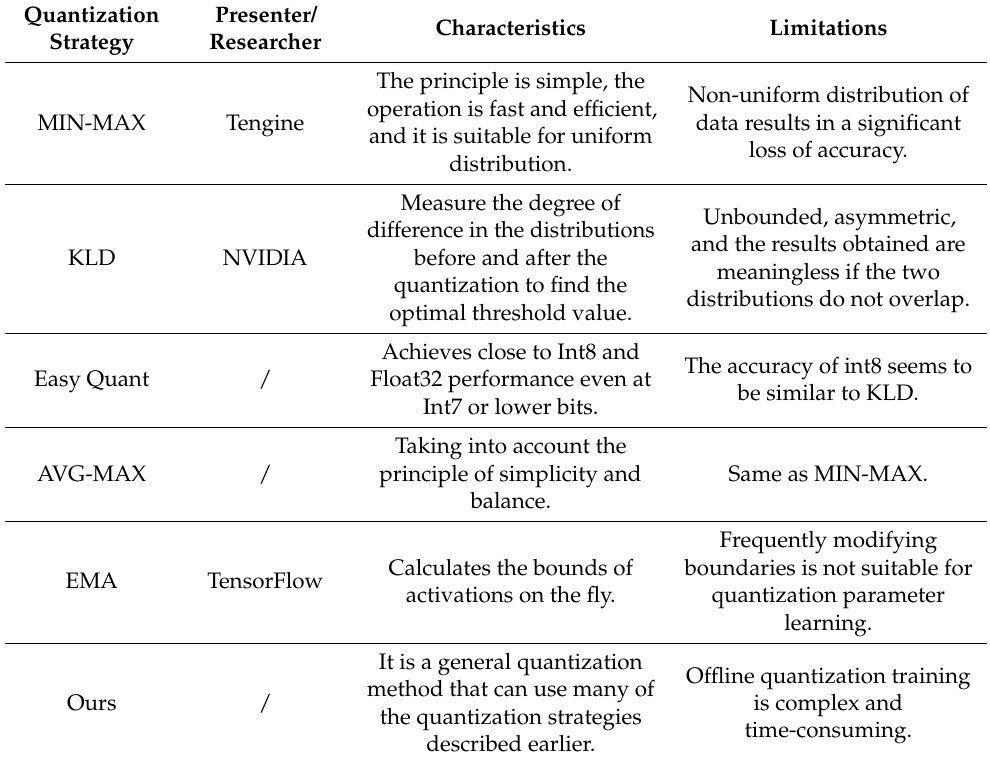
Table 1. Comparison table of key characteristics and limitations of quantization